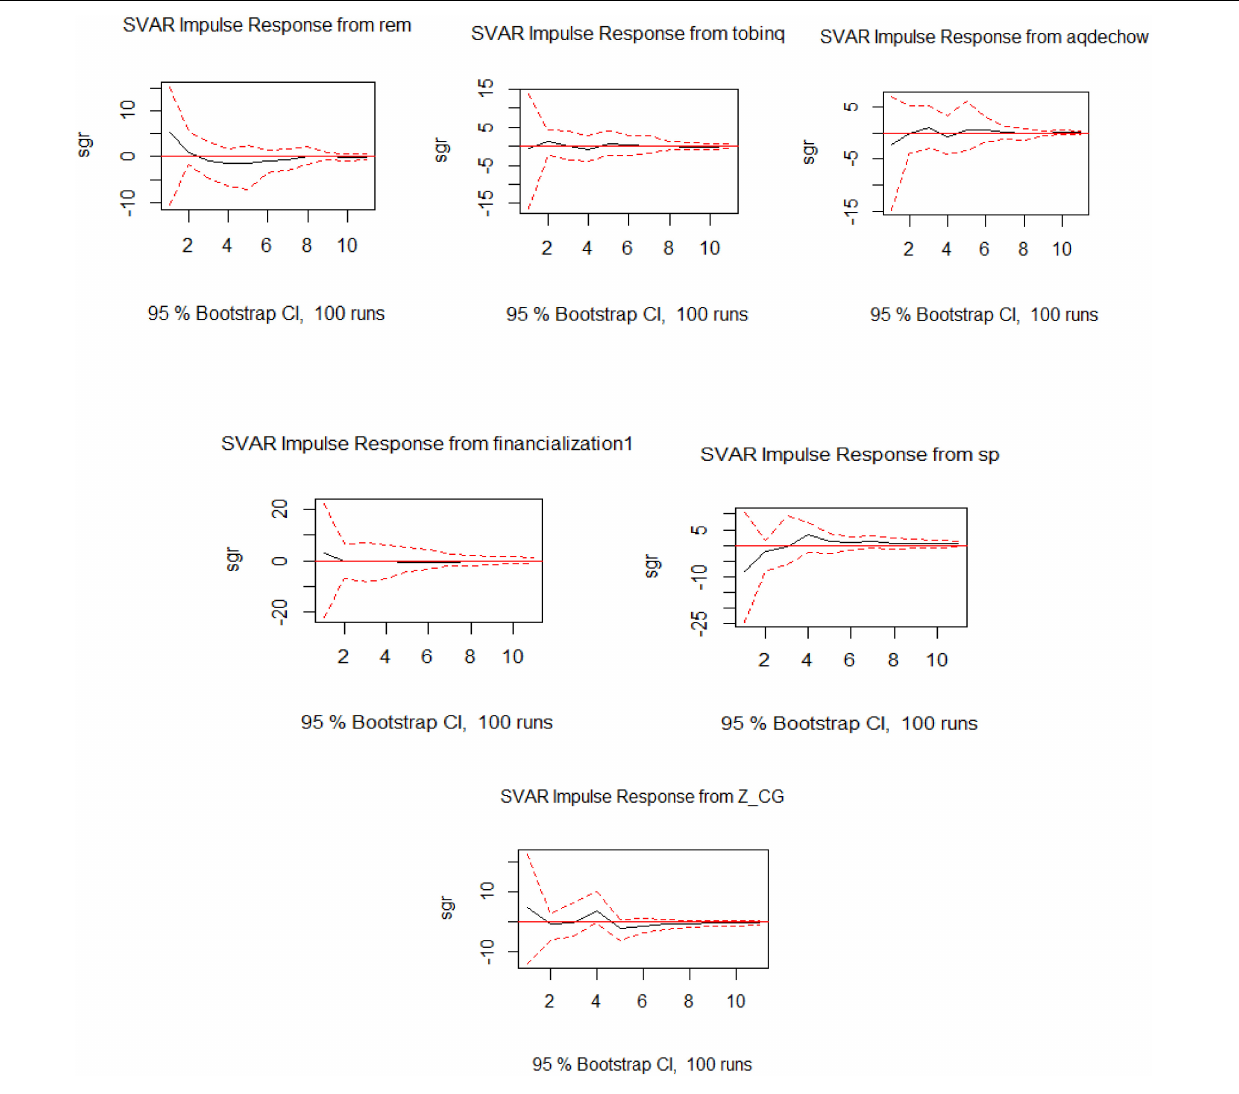
FIGURE 6 | Visualization of IRF for SVAR for Model